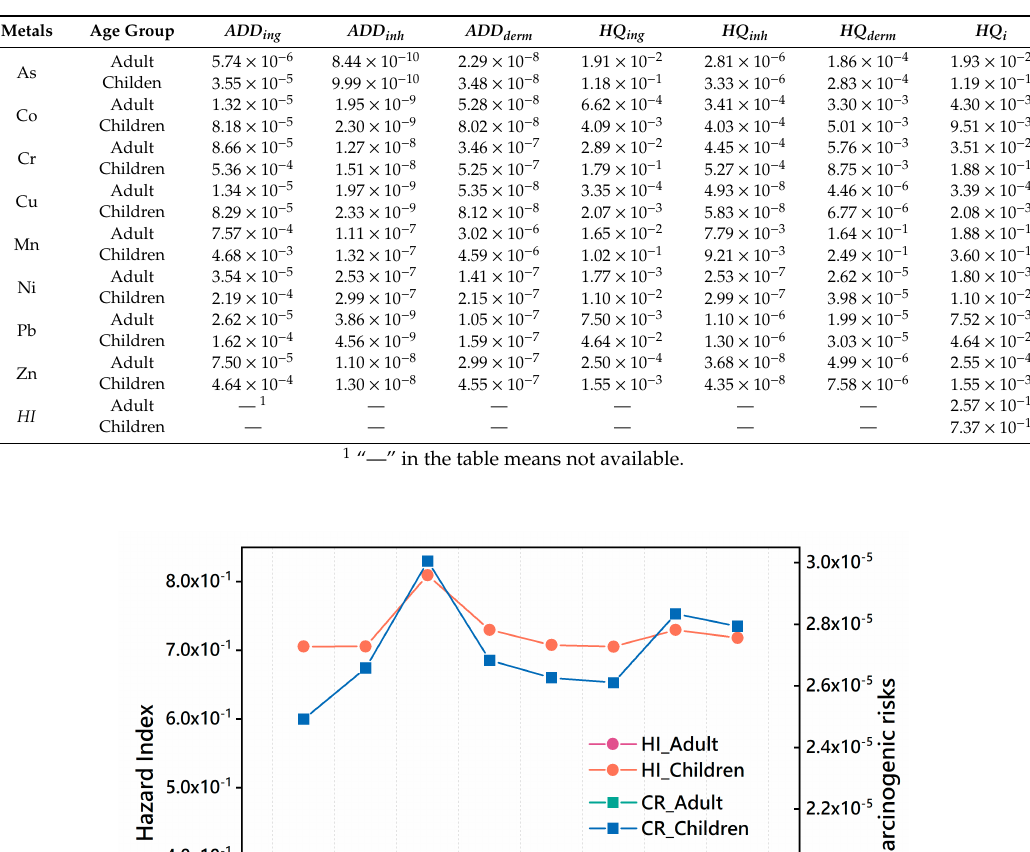
Table 4. Daily exposure and non-carcinogenic risk index for adults and children with PHEs and pathways in 0–40 cm soil layer.